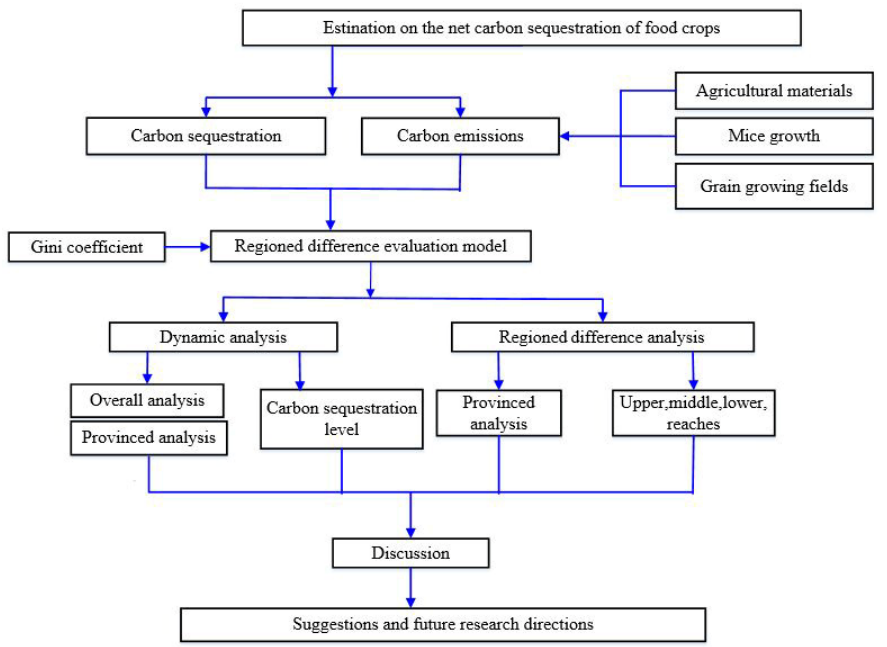
Figure 2. Research Figure 2. Research framework .